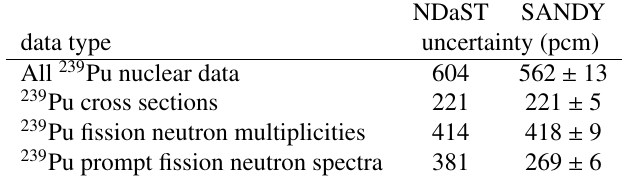
Table 1: k e ff uncertainty prediction for Jezebel using SANDY and NDaST. Uncertainties calculated with SANDY are given together with an estimate of the variance of variance.